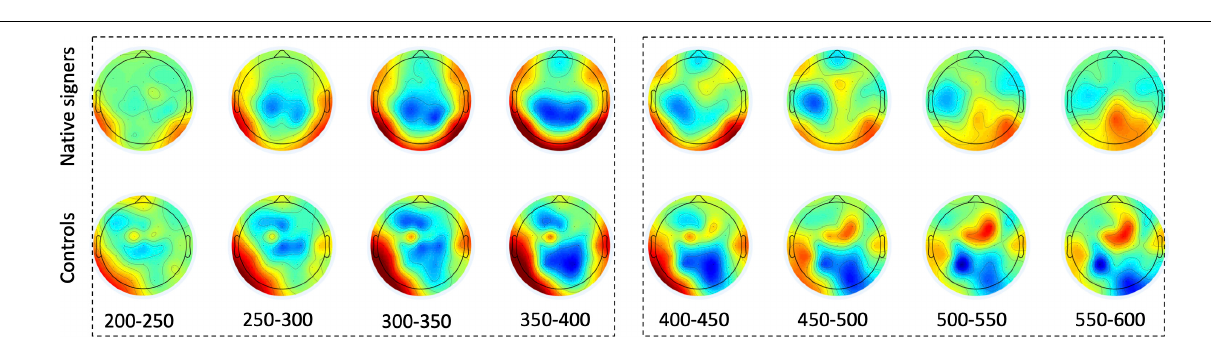
FIGURE 6 | Topographical voltage maps of the difference waves (Unrelated – Overlapping) for Native signers (upper panels) and Controls (lower panels) between 200 and 600 ms post-stimulus in 50 ms increments. Dashed boxes indicate time windows used for measurement. Green indicates zero, colors toward dark red indicate a positive difference, colors toward dark blue indicate a negative difference. Nose is at the